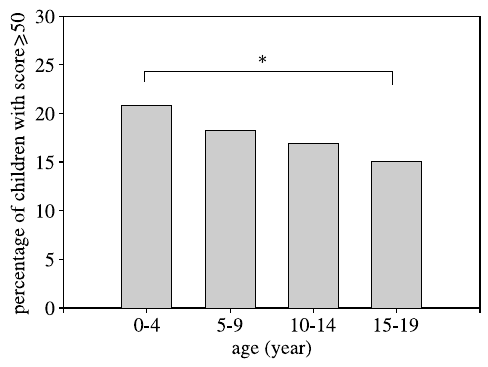
Figure 1. The prevalence of atopic dermatitis in various age groups. The skin status and atopic history of 1145 children living in East-Hungarian agricultural urban and rural areas were evaluated using the Schultz-Larsen questionnaire. Children with score $ 50 were considered to have atopic dermatitis. Comparison of various age groups revealed statistically significant difference between the youngest (age 0–4) and the oldest (year 15–19) children groups with AD. * p ,